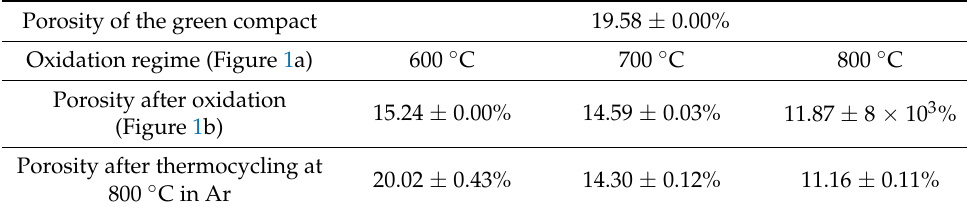
Table 2. Evolution of the green compact porosity after oxidation at 600 ◦ C, 700 ◦ C, and 800 ◦ C and after subsequent thermocycling at 800 ◦ C in an inert argon atmosphere. Figure 13. Relative elongation ( a ) and coefficient of the thermal expansion ( b ) were observed for the green body compact oxidized to 800 °C and subsequently thermocycled to 800 °C in the Ar atmosphere.